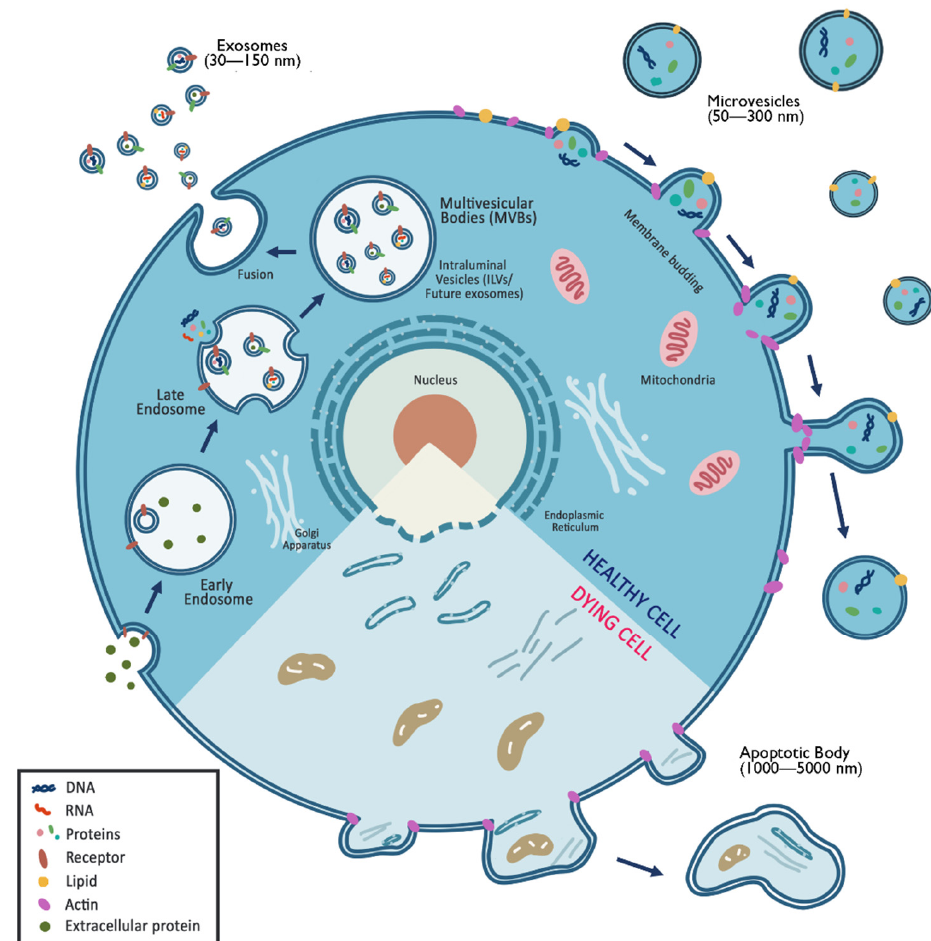
Figure 2. General classification and biogenesis of extracellular vesicles.